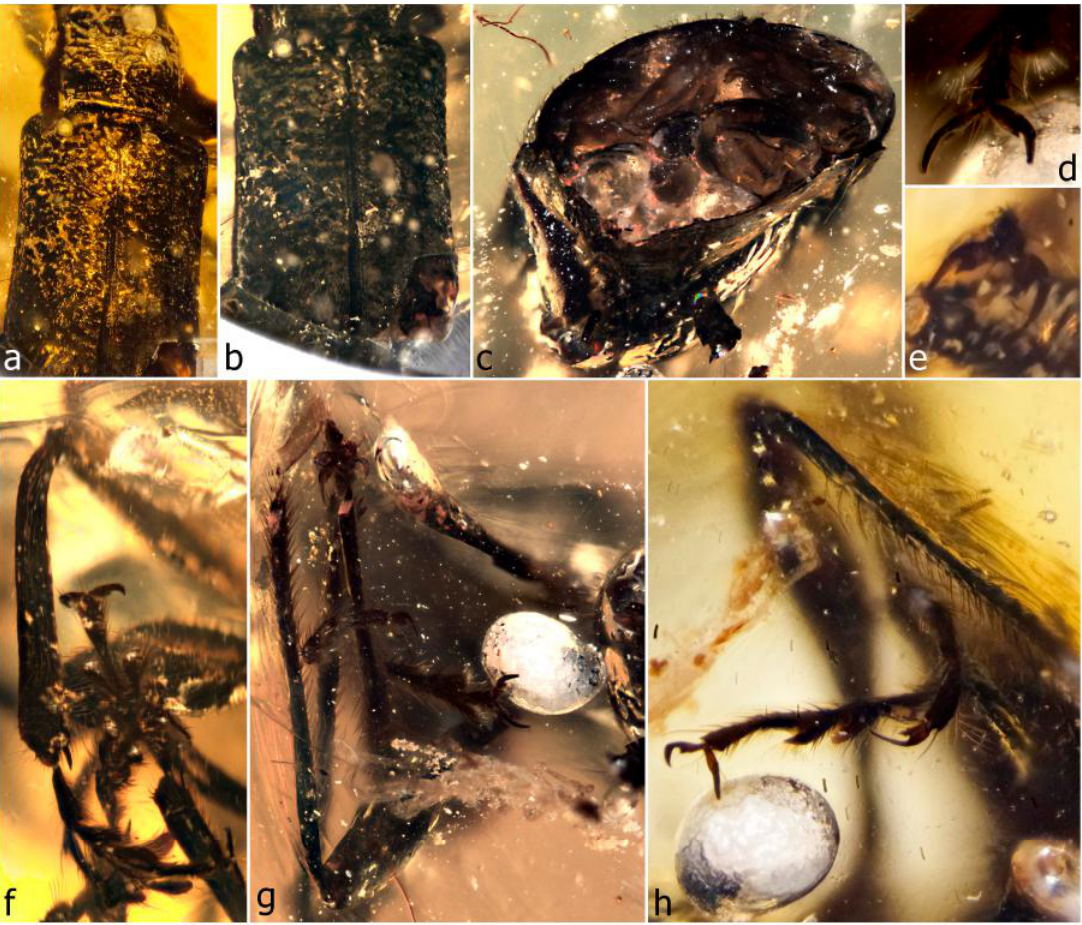
Figure 18. Rhynchitomimus chalybeus sp. n., holotype. Pronotum and elytra, dorsal ( a ); elytra ( b ); cut-away end of abdomen ( c ); tarsal claw, doso-apical ( d ); tarsal claw, apical ( e ); tibiae and details of legs ( f – h ).